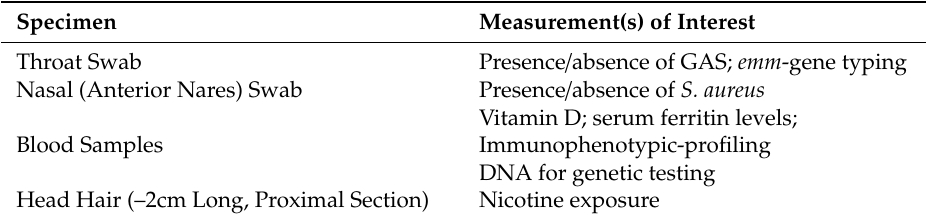
Table 3. Specimens collected for study and associated exposure(s) of